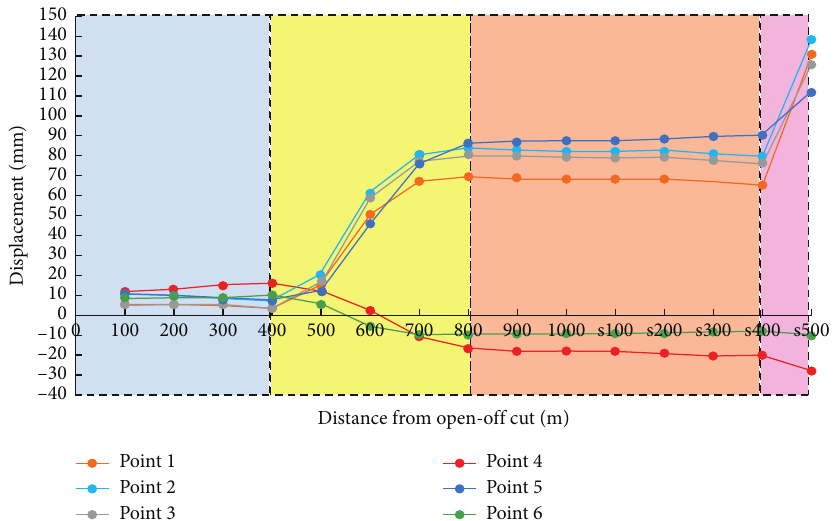
Figure 12: Displacement of monitoring point 500m from the open-off cut.